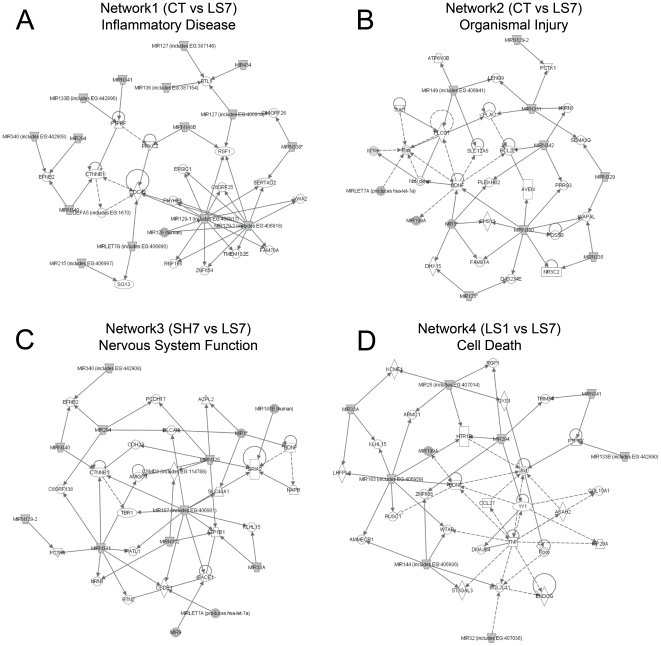
Selected networks affected by microRNA expression changes according to Ingenuity Pathway Analysis (IPA).Each node represents molecules (microRNAs, gene) and the biological relationship between two nodes is represented as a line. These networks include microRNAs with expression changes obtained by comparison of the injury 7dpo group (LS7) with respectively non-injured control group (CT)(network 1 and 2), Sham 7dpo group (SH7)(network3) and injury 1dpo (LS1) (network4). The top four functions associated with networks are (A) Inflammatory Disease, Cell Morphology, Cellular Assembly and Organization, (B) Organismal Injury and Abnormalities, Cardiac Damage, Cardiovascular Disease, (C) Nervous System Development and Function, Tissue Morphology, Cellular Development and (D) Cell Death, Nervous System Development and Function, Cellular Function and Maintenance.